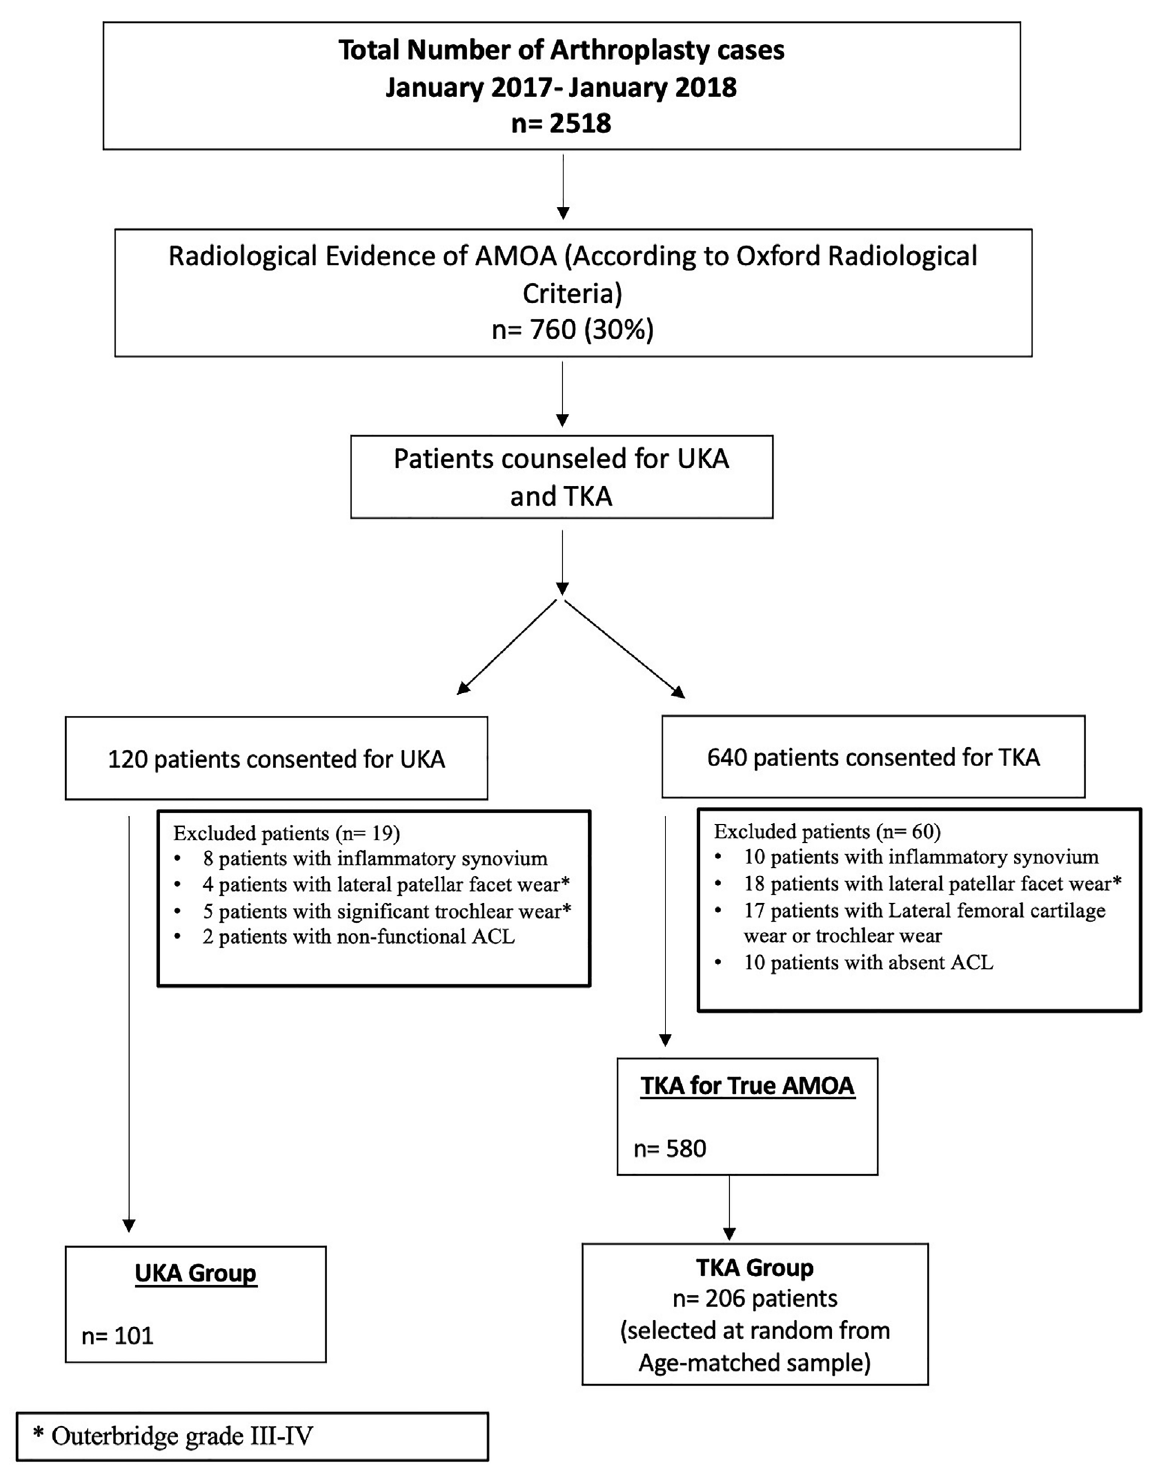
Figure 1. Flowchart for case allocation in the UKA and TKA cohorts. *Patients excluded based on the Outerbridge Classi fi cation of cartilage wear of the patello-femoral